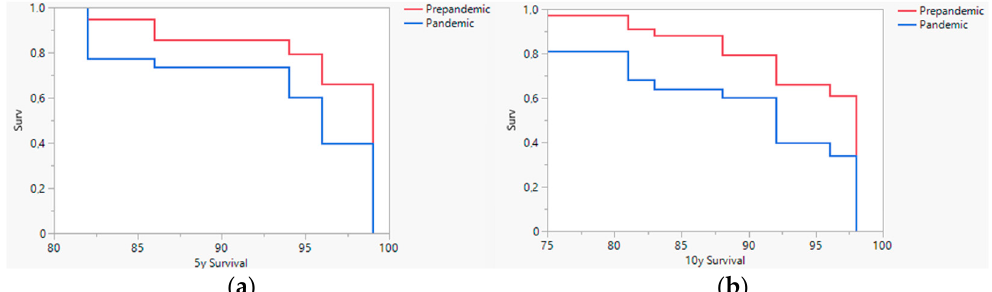
Figure 3. 5-year ( a ) and 10-year ( b ) Kaplan-Meier survival analysis. The estimated survival analysis showed worse estimated survival in patients diagnosed after the pandemic.